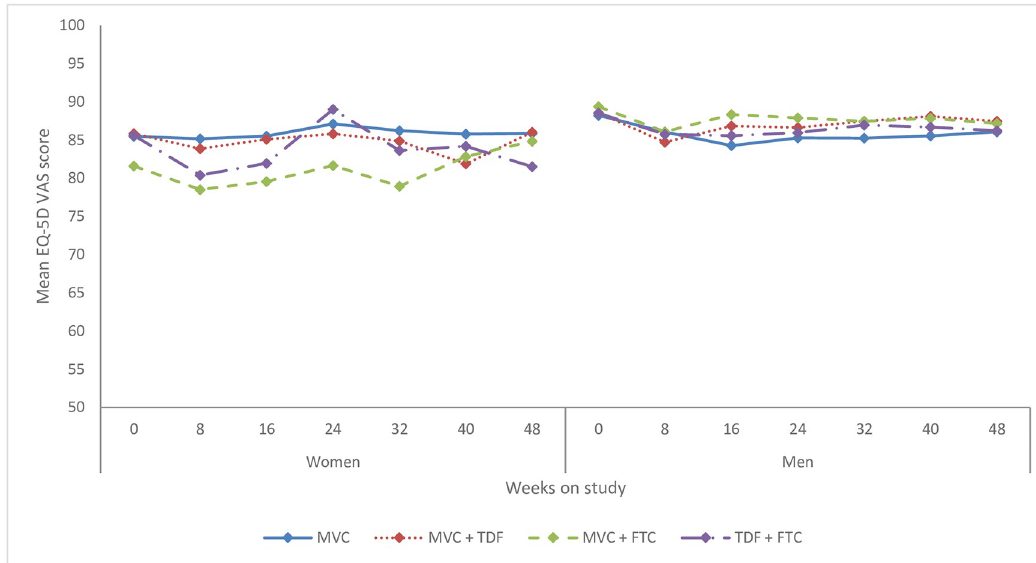
Fig 2. Mean EQ-5D visual analogue scale (VAS) score by PrEP study regimen over time. Mean utility measured by EQ-5D VAS, where 0 is the worst health the respondent can imagine, and 100 is the best. MVC = maraviroc, TDF = tenofovir disoproxil fumarate, FTC =